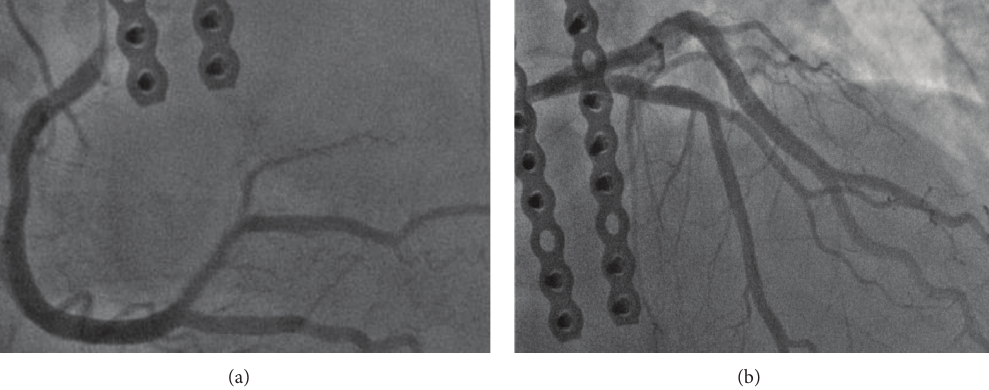
Figure 2: (a) Coronary angiogram showing right coronary artery. (b) Coronary angiogram showing left coronary